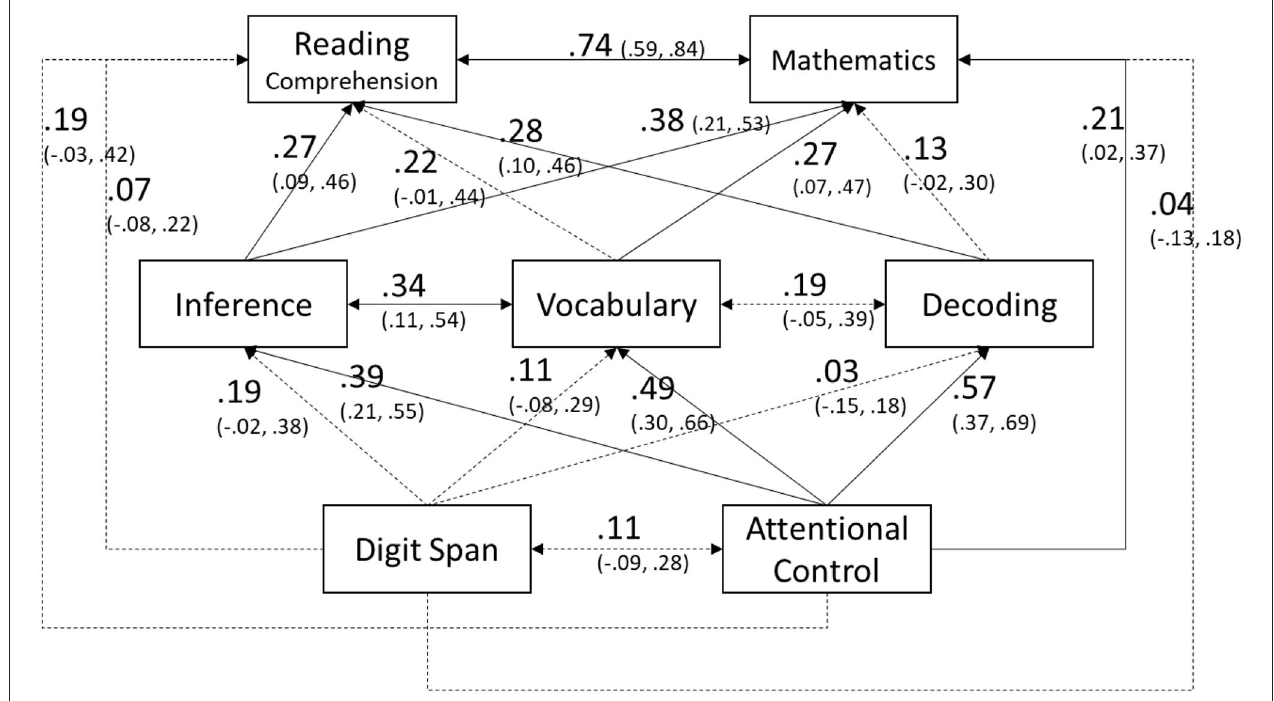
FIGURE 1 | Standardized path coefficients (95% confidence intervals) where language and cognitive skills predict reading comprehension and mathematics. Solid lines represent statistically significant paths ( p < 0.05) whereas dashed lines represent non-significant